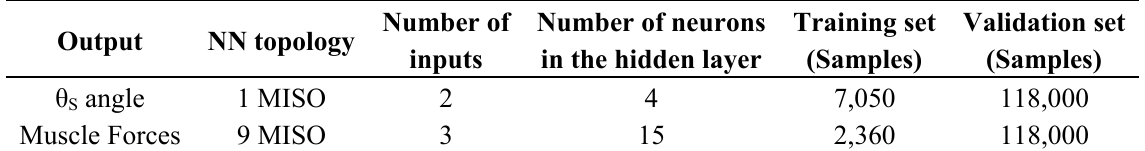
Table 1. Parameters of Neural Networks (NN) used to obtain the results.